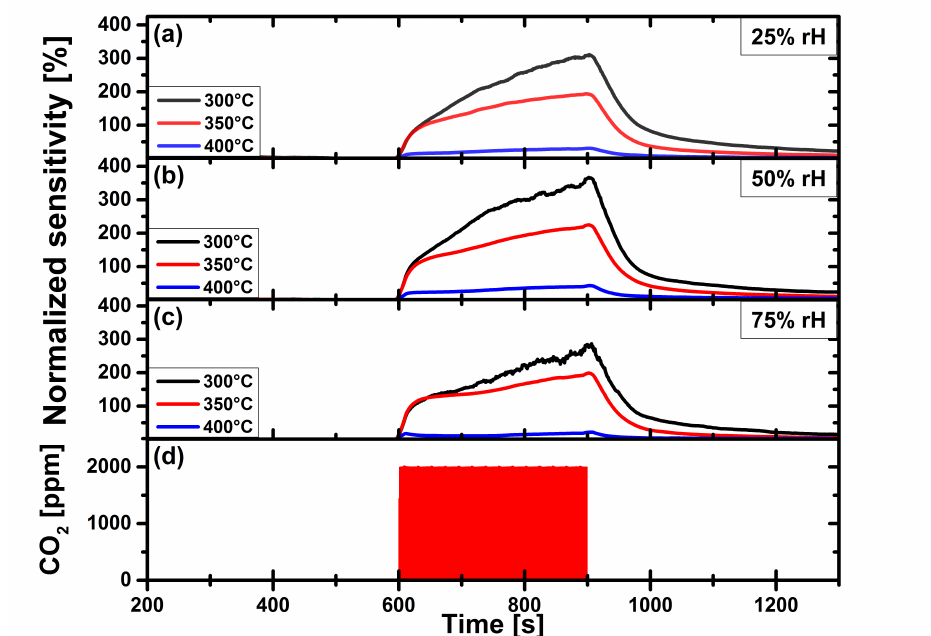
Figure 8. Carbon dioxide measurement of gold nanoparticles functionalized CuO gas sensor, at operation temperatures 300 ◦ C, 350 ◦ C and 400 ◦ C, at constant relative humidity levels of: ( a ) 25%.